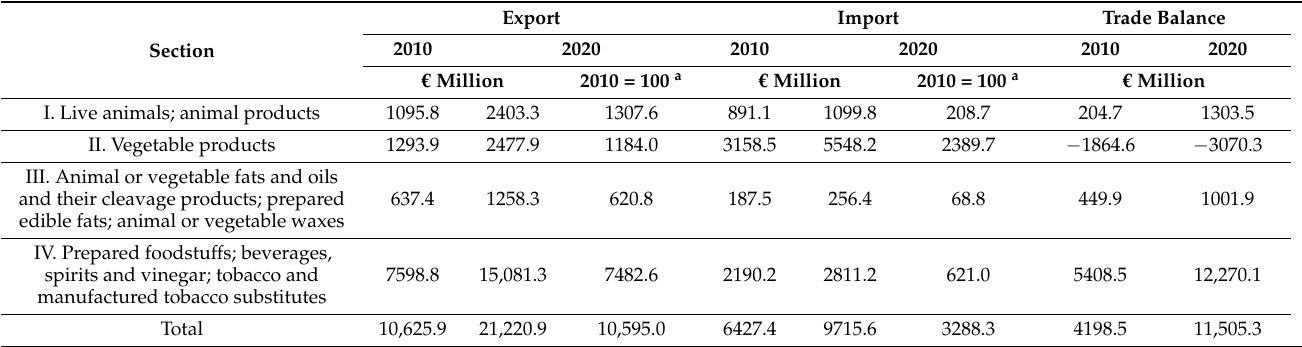
Table 3. Value and trade balance of agri-food trade between the EU and the US in 2010 and 2020 by the Combined Nomenclature (CN) sections ( €